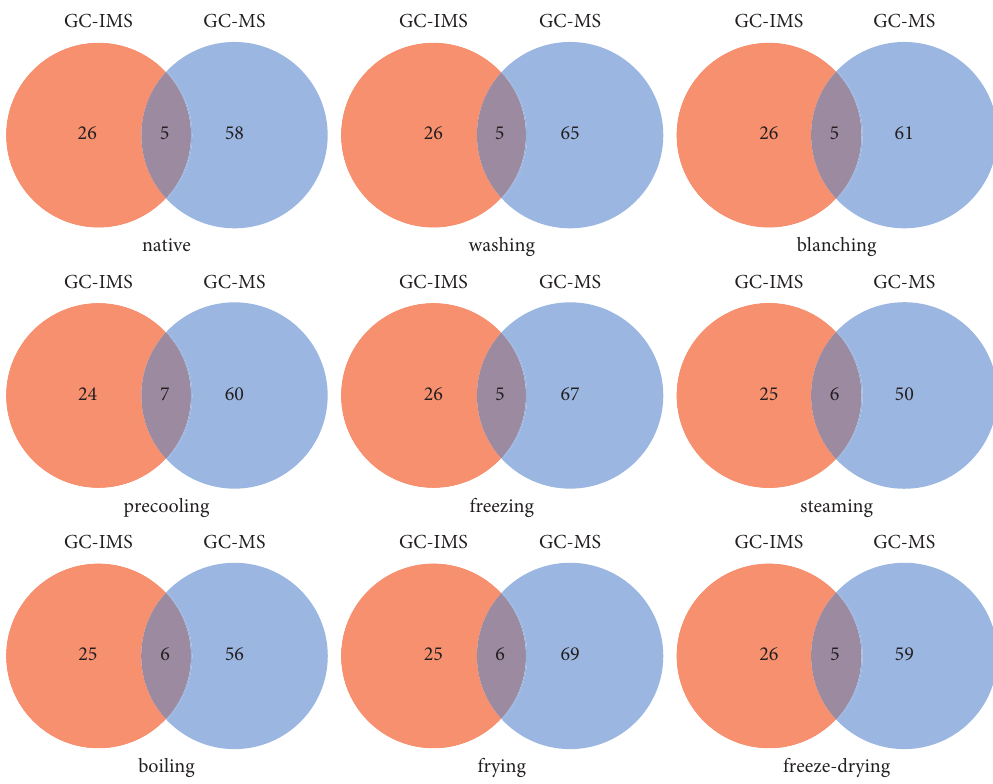
Figure 4: Wayne diagram of the flavor of GC-MS and GC-IMS under different treatment